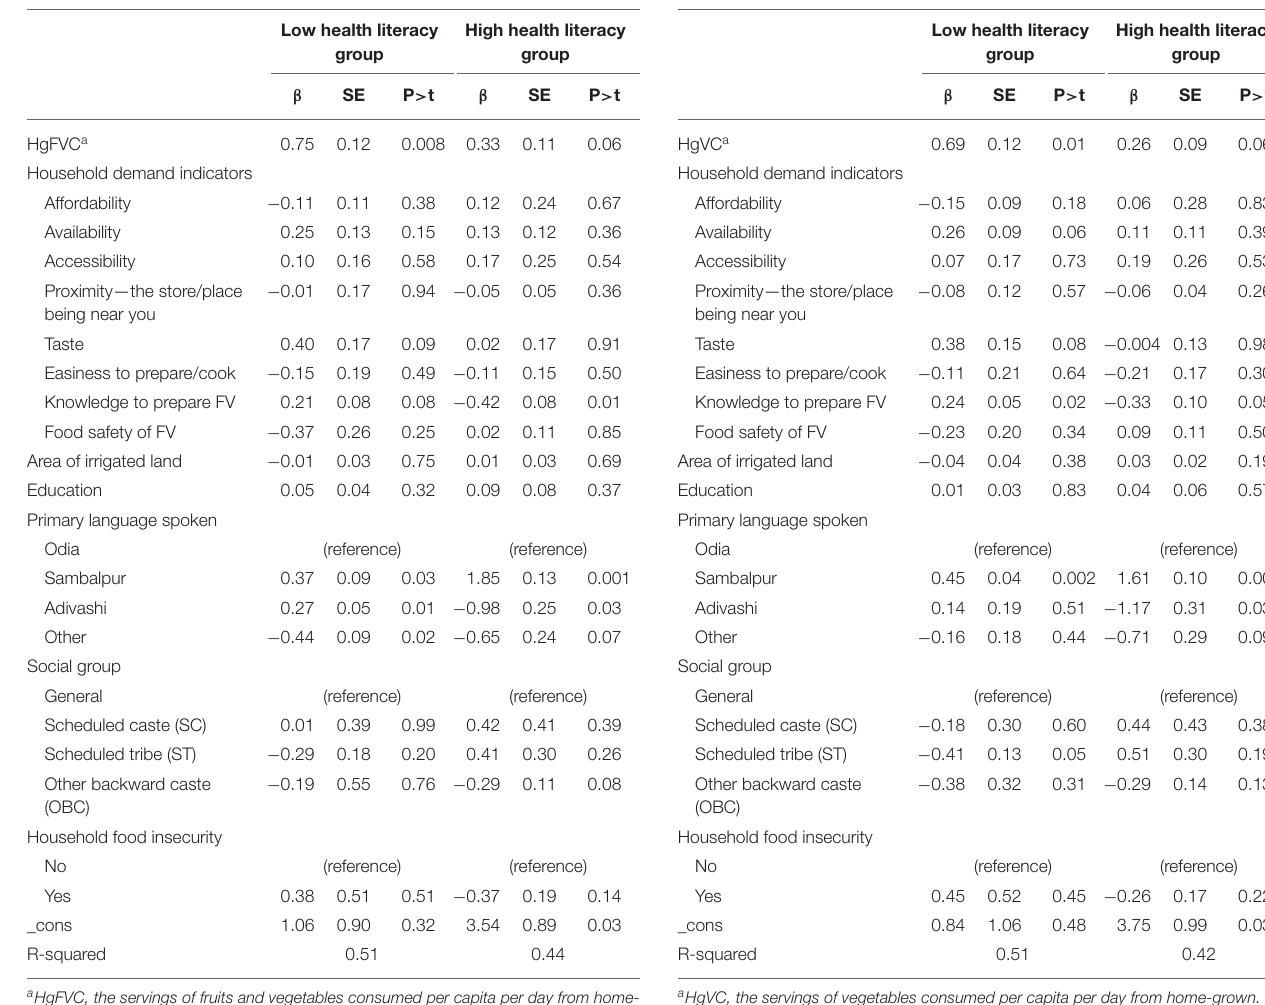
TABLE 3 | Subpopulation analyses for the servings of fruits and vegetables consumed per capita per day by high-/low-health literacy groups.